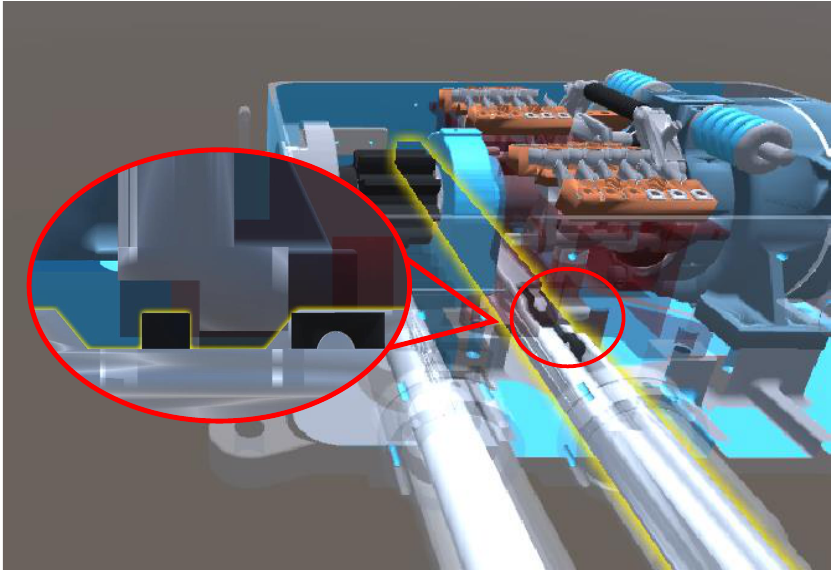
Figure 8. The diagram of the virtual model